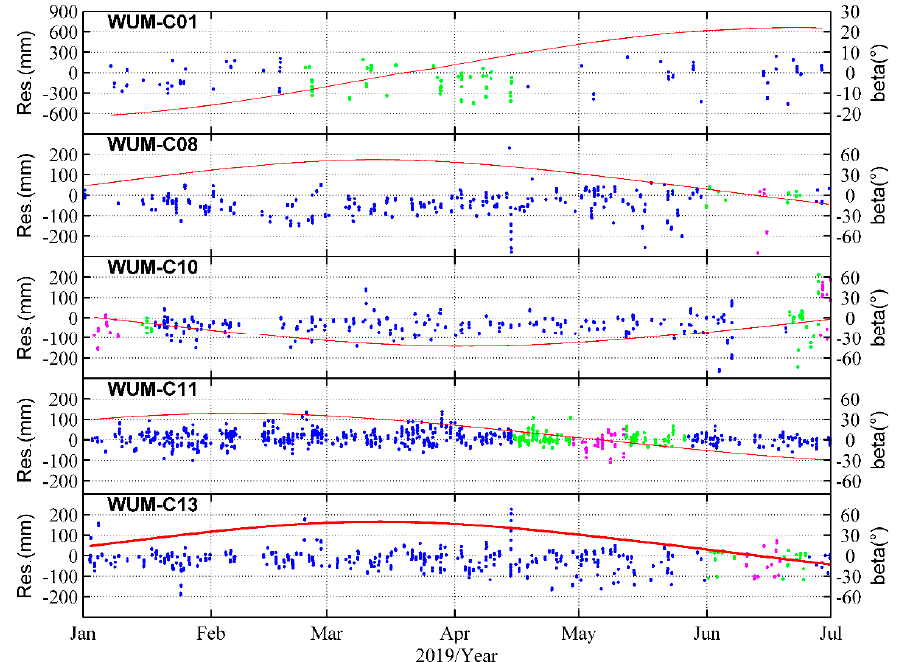
Figure 4. The SLR validation time series for BDS-2 satellites derived from WUM in the half-year time series since 2019. The blue scatters, green scatters, magenta scatters, and red line refer to the Sun elevation angle of β , the SLR residuals during the non-eclipse period, the Normal Yaw Steering (NYS) of the eclipse period, and the Yaw Manoeuver (YM) period respectively. The definitions of these concepts for BDS-2 satellites were summarized and described in Yang, Xu, Nie, Gao and Guan [20], and we apply exactly the same SLR validation strategy in this